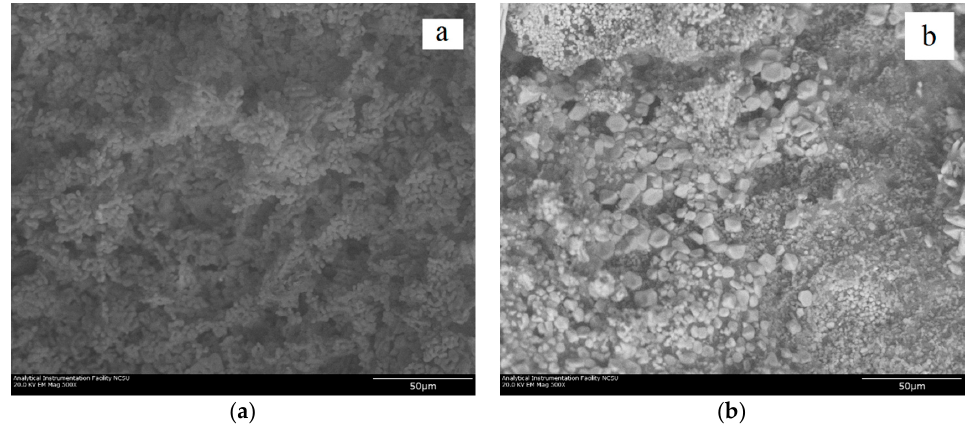
Figure 5. SEM images of COS ( a ) and Na-COS ( b ).